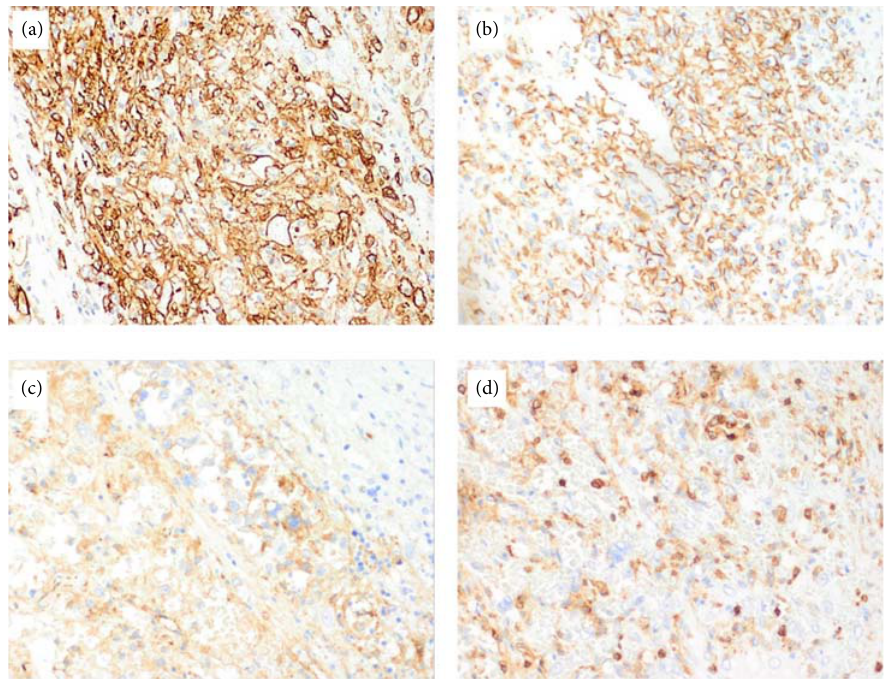
Figure 5: Immunohistochemistry shows the large tumor cells are positive for vascular markers (a) CD34, (b) CD31, and (c) vWF. Only small residual lymphocytes are positive for (d) CD45, and the large atypical cells are